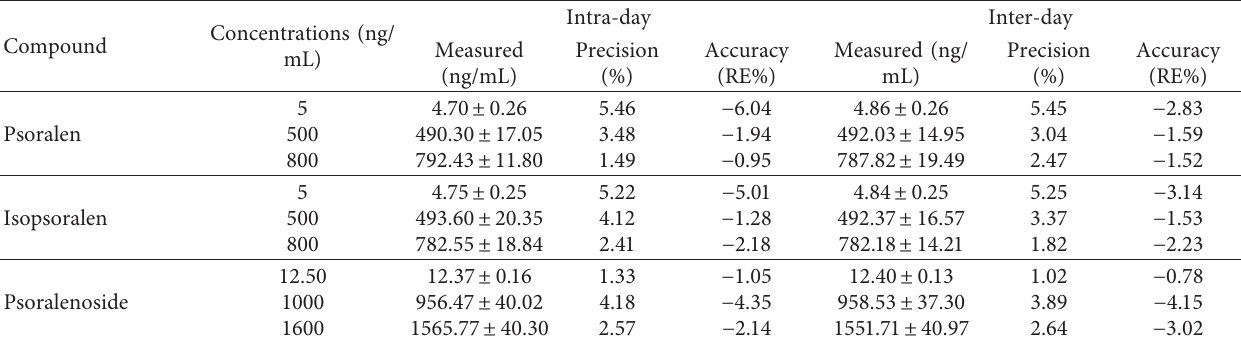
Table 3: Intraassay and interassay precision and the accuracy of 12 kinds of compounds in rat kidney ( n � 6).